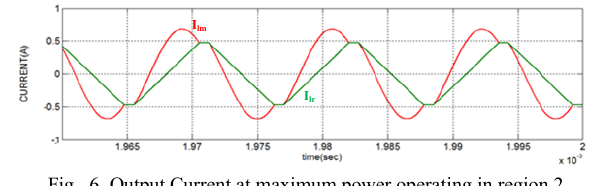
Fig. 6. Output Current at maximum power operating in region 2